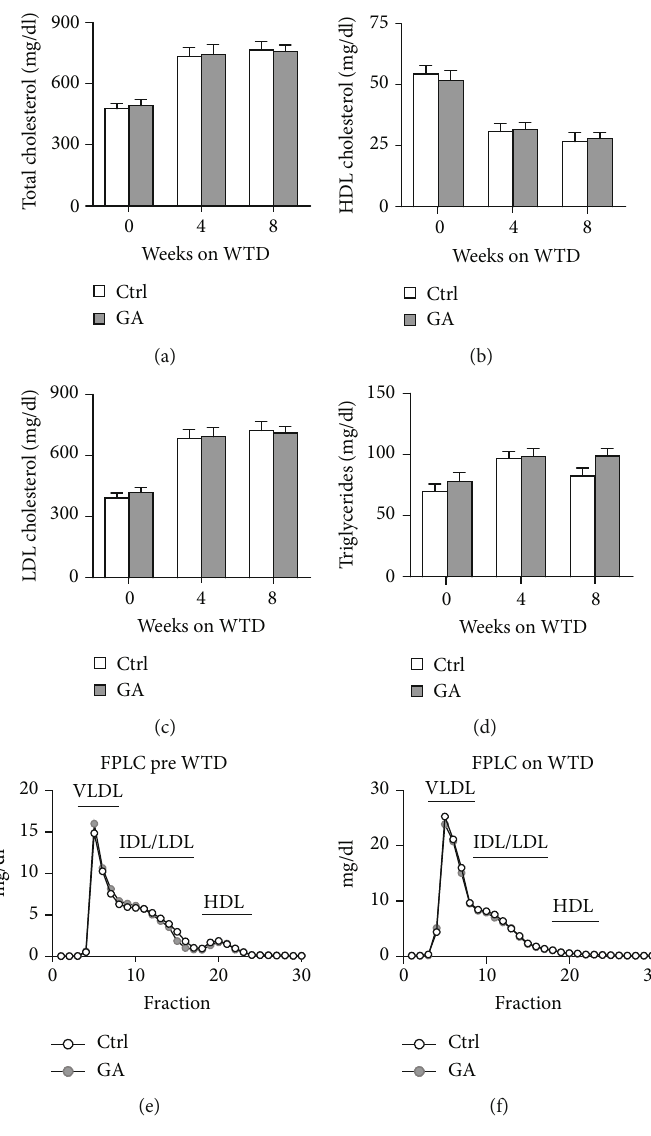
Figure 1: E ff ect of low-dose GA administration on diet-induced hyperlipidemia in the Apoe KO mice. (a – d) Plasma total cholesterol (a), high-density lipoprotein cholesterol (b), low-density lipoprotein cholesterol (c), and triglycerides (d) levels during WTD feeding, n = 8 per group. (e, f) Plasma lipoprotein pro fi les fractioned by a fast protein liquid chromatography (FPLC) before and after 8 weeks on WTD feeding. Samples were pooled from 5 mice of the same